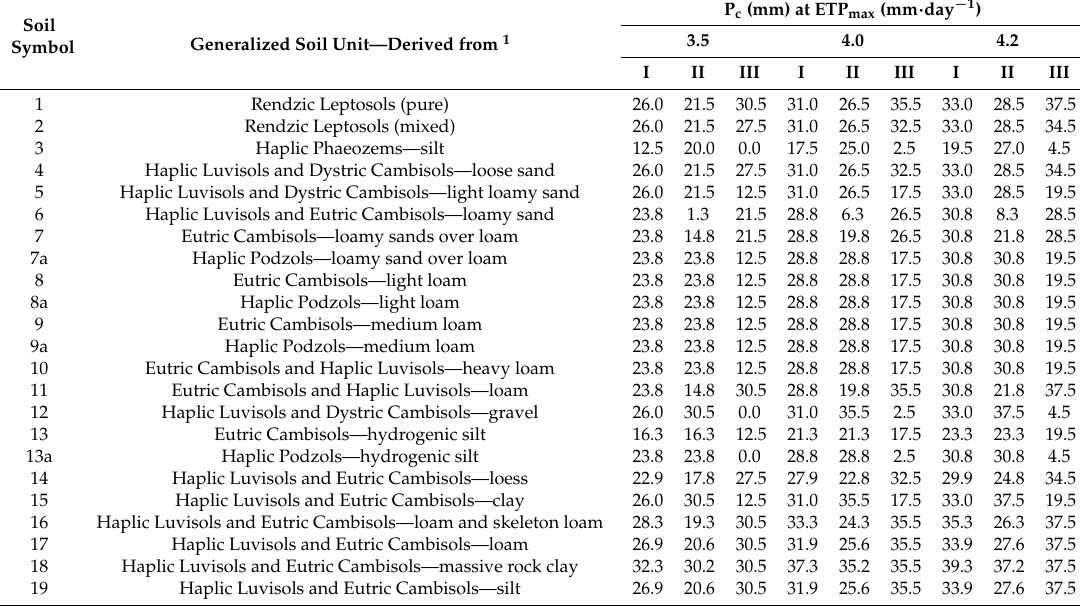
Table 2. Critical precipitation P c in a decade (10-day period) preventing readily available soil water deficit in arable soils in Poland under conditions of maximum evapotranspiration ETP max . Soil